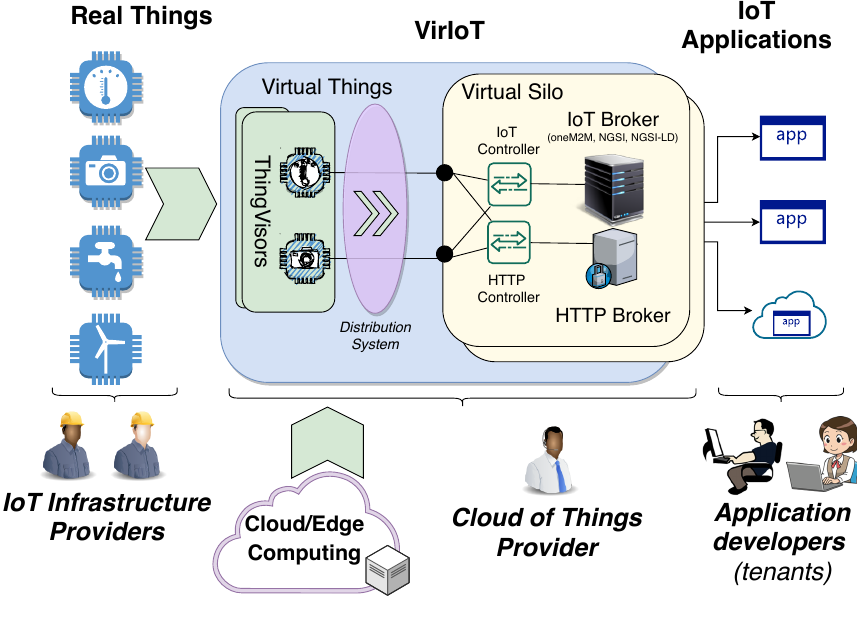
Figure 2. IoT Applications based on VirIoT